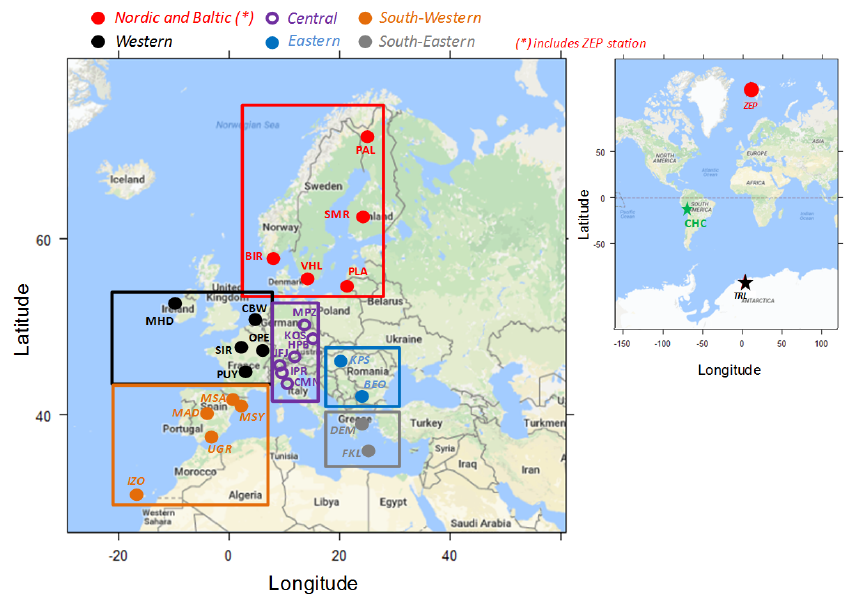
Figure 1. Locations of the 28 ACTRIS stations included in this